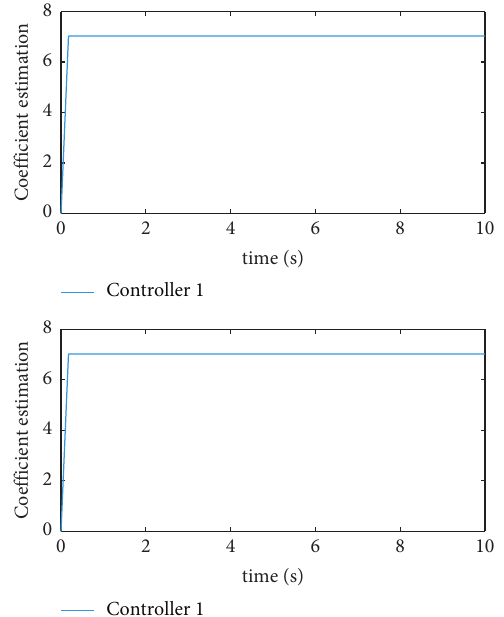
Figure 4: Reaching law coefficient c